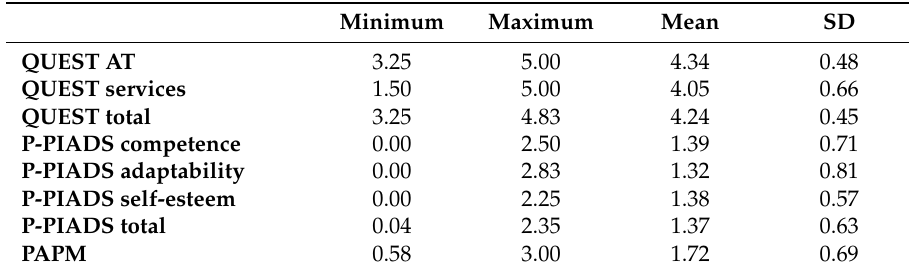
Table 2. Satisfaction with AT, psychosocial impact of AT and participation